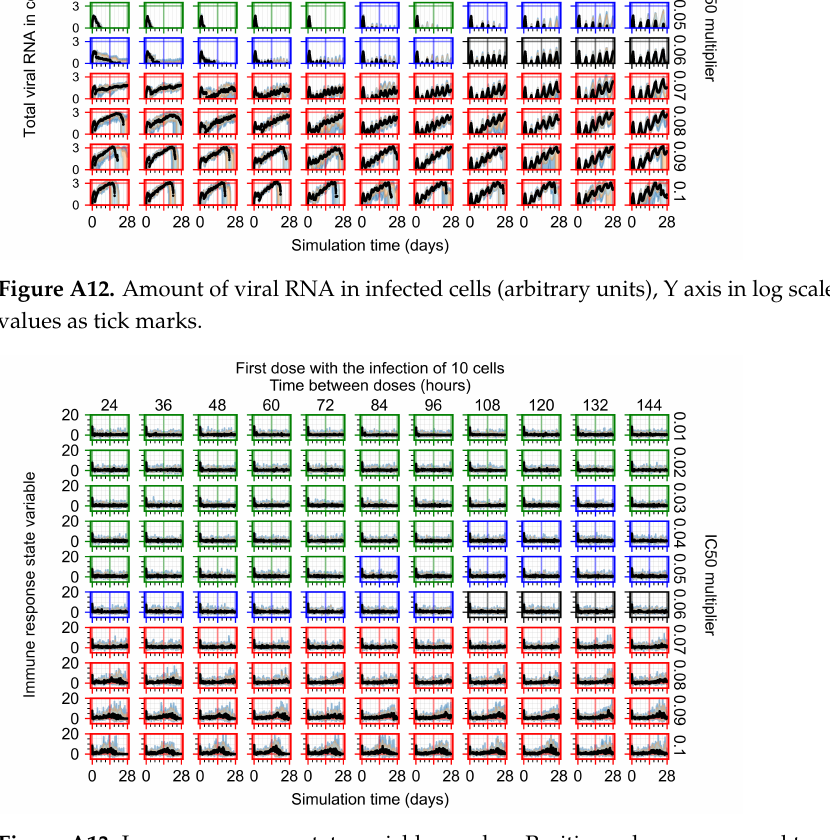
Figure A13. Immune response state variable number. Positive values correspond to an inflammatory state, and negative to an anti-inflammatory